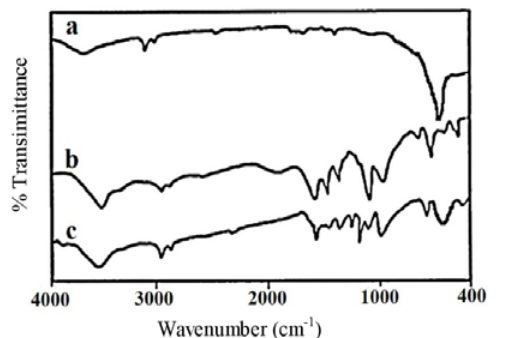
nanoparticles, (b) pure 2